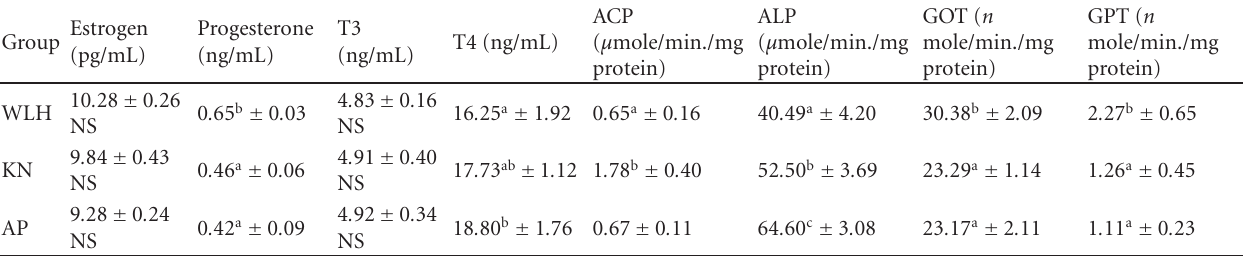
Table 1: Age-dependent variation in hormonal concentration and biochemical constituents of blood plasma (6thwk) in di ff erent breeds of Indian native hen (Mean ± S.E.M, n = 6).